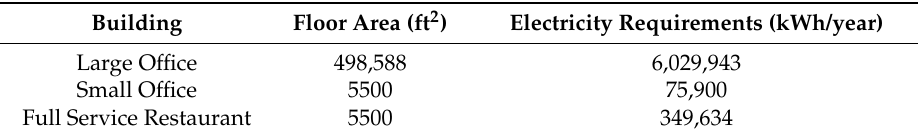
Table 1. Areas and electricity requirements for the modeled buildings [27].